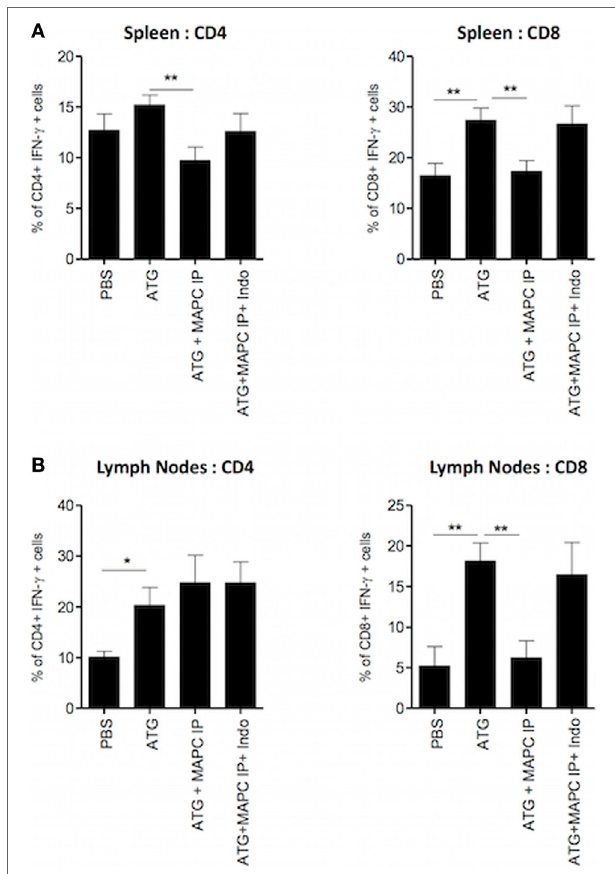
FigUre 6 | Multipotent adult progenitor cells (MAPC) administered intraperitoneally (IP) require prostaglandin E2 (PGE2) to suppress interferon- γ (IFN- γ ) production by T cells. 100 mg/kg anti-thymocyte globulin (ATG) or control serum was administered over two doses given on days 0 and 3, followed by the administration of MAPC IP on day 4, and indomethacin (Indo) on days 4, 5, and 6. Spleens and lymph nodes were harvested on day 7 and examined for the production of IFN- γ by T cells. Bar graphs show that suppression of IFN- γ production by CD4 + and CD8 + T cells in the (a) spleen [PBS: n = 7, ATG: n = 7, ATG + MAPC IP: n = 9, and ATG + MAPC intravenous (IV): n = 7] and (B) lymph nodes (PBS: n = 4, ATG: n = 5, ATG + MAPC IP: n = 5, and ATG + MAPC IV: n = 4) was inhibited when Indo was administered on days 4, 5, and 6 of the lymphodepletion model. Results are indicative of two independent experiments using two MAPC donors. * p < 0.05 and ** p < 0.01. FigUre s1 | Multipotent adult progenitor cells (MAPC) suppress IL-7-induced